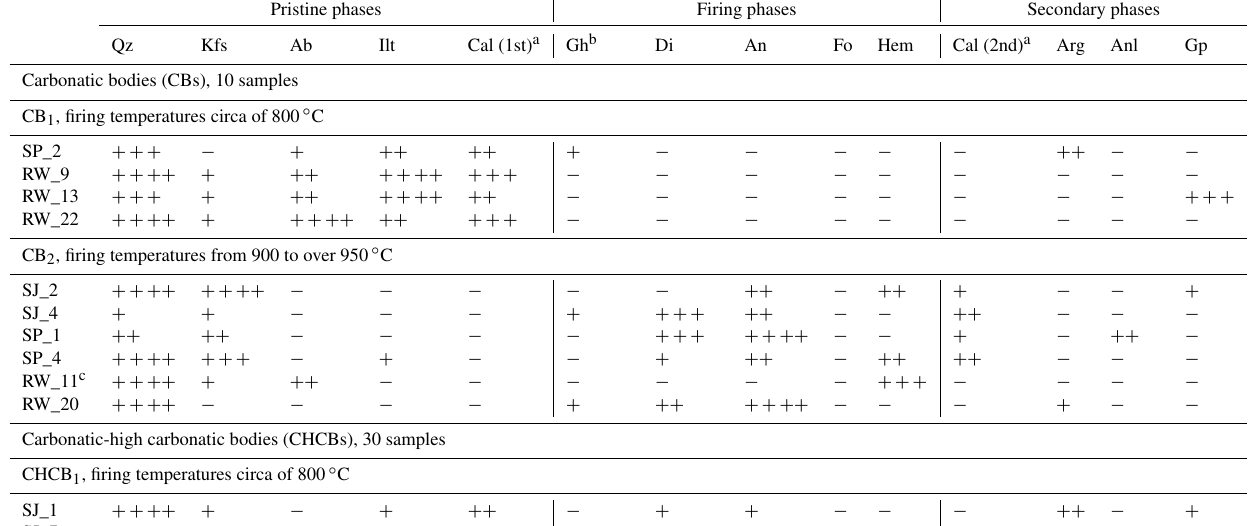
Table 2. Mineralogical associations detected by XRPD analysis of the brick samples. Mineral abbreviations after Warr (2021): quartz (Qz); K- feldspars (Kfs); albite (Ab); illite (Ilt); calcite (Cal); gehlenite (Gh); diopside (Di); anorthite (An); forsterite (Fo); hematite (Hem); aragonite (Arg); analcime (Anl); gypsum (Gp). Secondary calcite (Cal (2nd)) was estimated on the basis of microscopic analysis. + : detected; ++ : noticeable; +++ : abundant; ++++ : very abundant; − : not detected. Pristine phases Firing